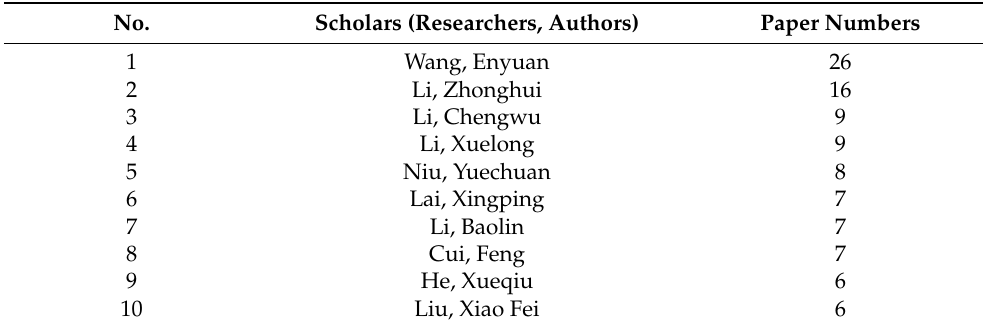
Table 5. The main scholars of China’s dynamic disaster monitoring and early warning international research